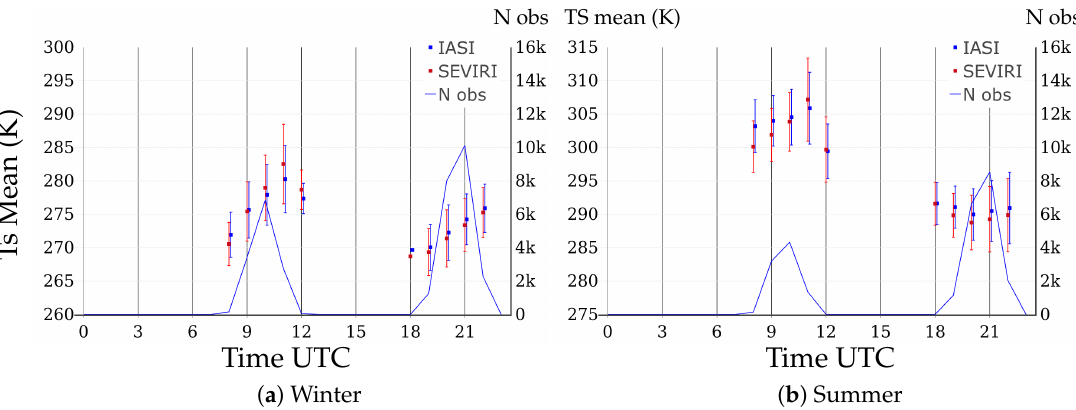
Figure 6. LST mean value from IASI (blue squares) and SEVIRI (red squares) LST for Winter 2018 period ( a ) and Summer 2018 period ( b ) as a function of AROME-France analysis time. The bars describe the associated standard deviations of the IASI/SEVIRI LSTs. The blue line shows the number of SEVIRI/model LST used data (as an example, for the winter period we used 2757 observations at 11UTC and 10126 observations at 21UTC).